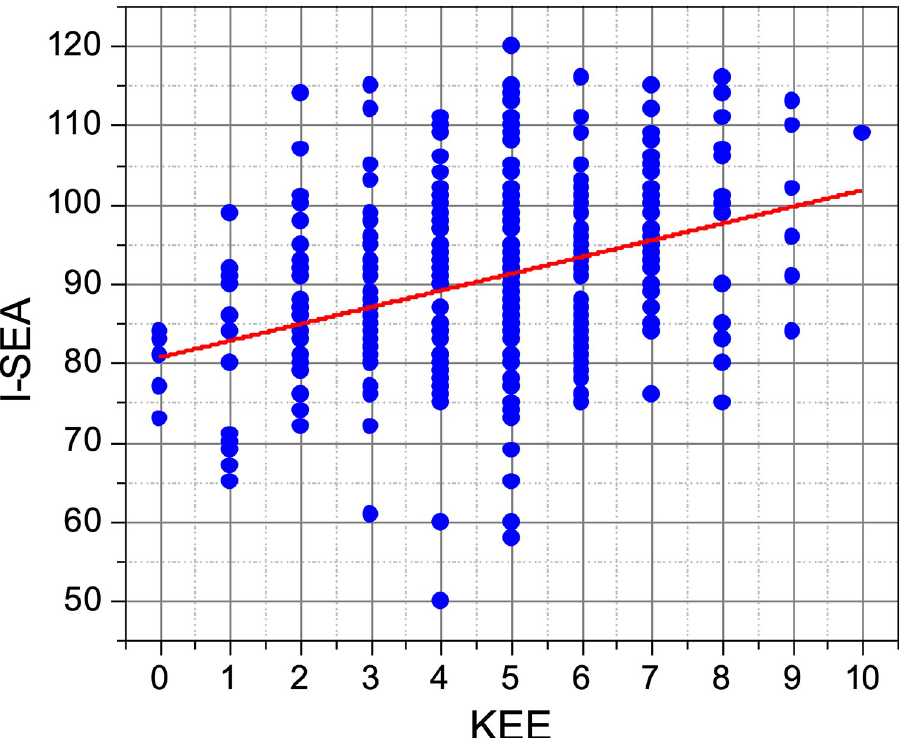
Fig 5. Relationship between acceptance and